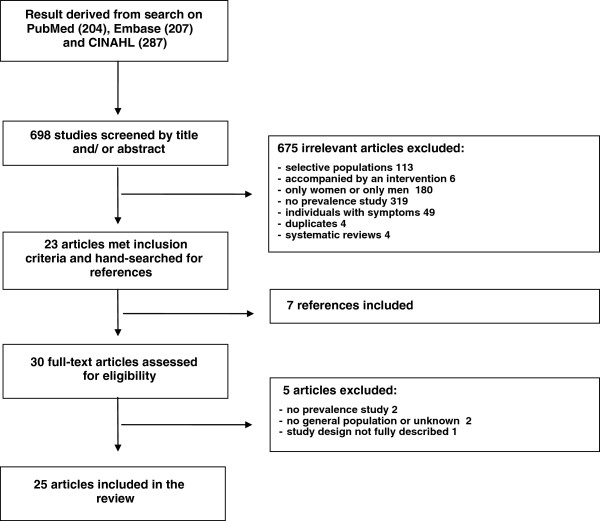
Flowchart of search, inclusions and exclusions from the systematic review.